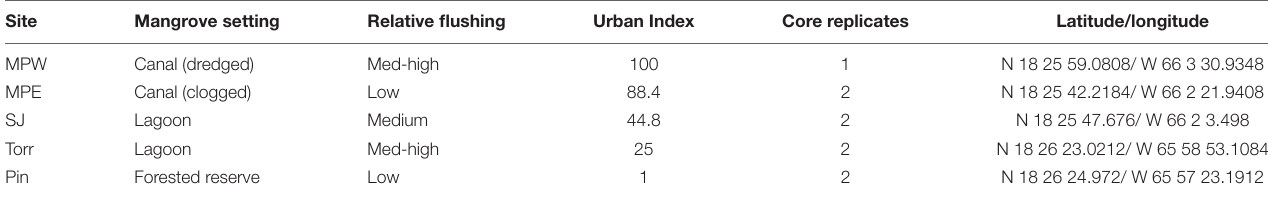
TABLE 1 | Categorical factors (landscape setting, flushing, and Urban Index) and the location (latitude/longitude) of the sampling sites. Site Mangrove setting Relative flushing Urban Index Core replicates